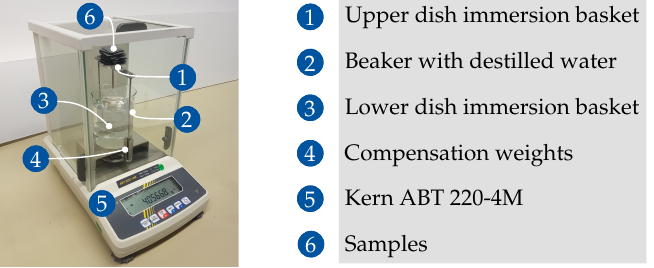
Figure 7. Analytical balance Kern ABT 220-4M with universal immersion